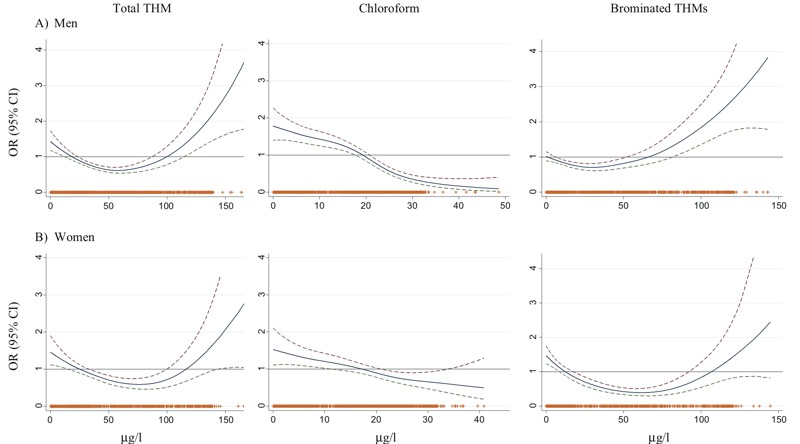
Exposure–response relationship between residential trihalomethane (THM) concentrations (x-axis, in micrograms/liter) and colorectal cancer (y-axis, expressed as odds ratios, ORs) among 1,837 cases and 3,454 controls. (A) Men. (B) Women.
Smoothed spline with 3 degrees of freedom from general additive models adjusted for sex, age, area, education, smoking, physical activity, nonsteroidal antiinflammatory drug use, and family history of cancer. Subjects with unsatisfactory questionnaires and subjects with THMs estimated for < 70% of the exposure window were excluded. p-Value gain compared with linearity is < 0.001 for all models, except for chloroform in women (p-value = 0.38). Tick marks above the x-axes represent observations, and the dashed lines represent the 95% confidence intervals (CIs).